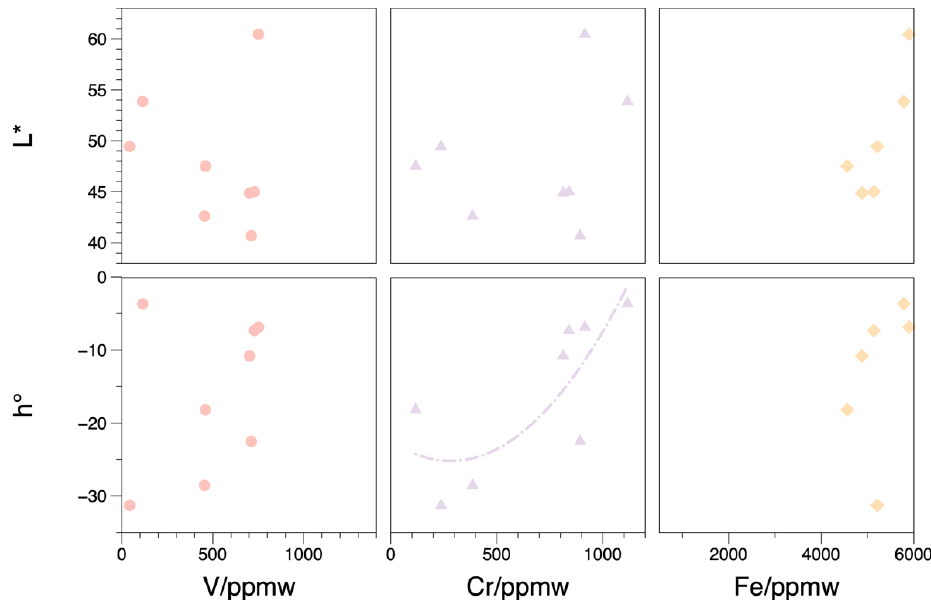
Figure 16. The relationship between V/Cr/Fe concentrations (ppmw) and the lightness/hue angle in Myanmar